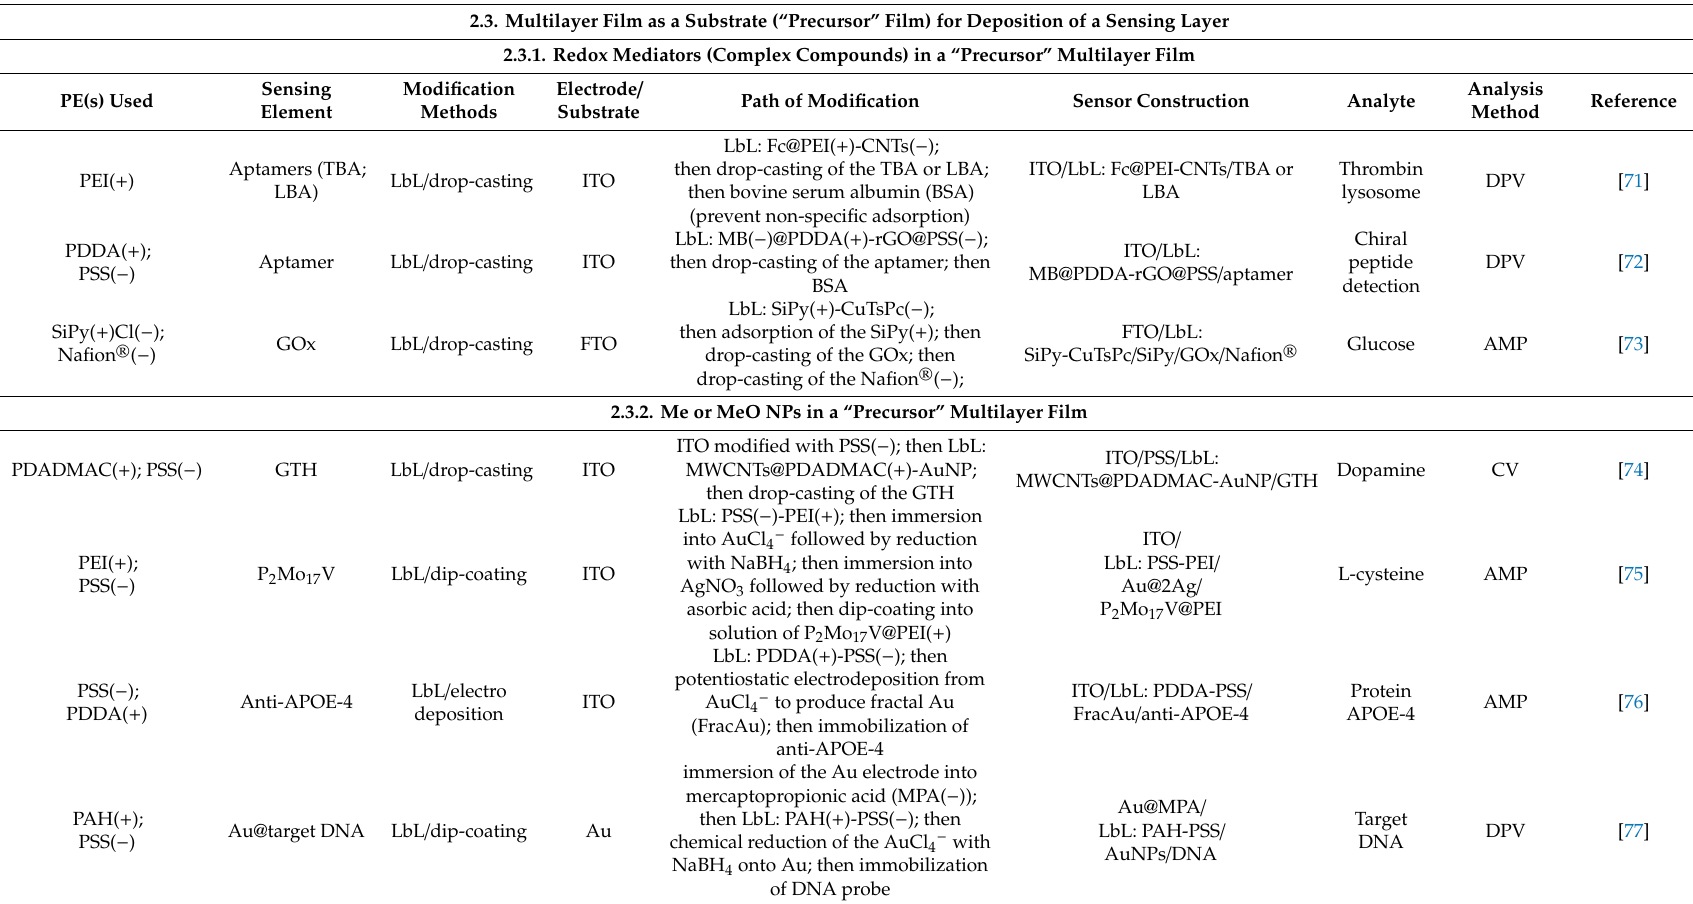
Table 3. Summary of electrochemical sensors based on the multilayer “precursor” film obtained using